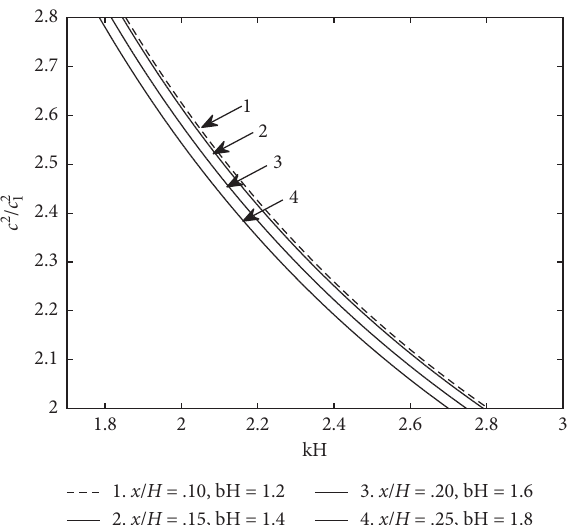
Figure 5: Model-II: effect of the initial stress ( P /2 L ) under soft mountain surface.